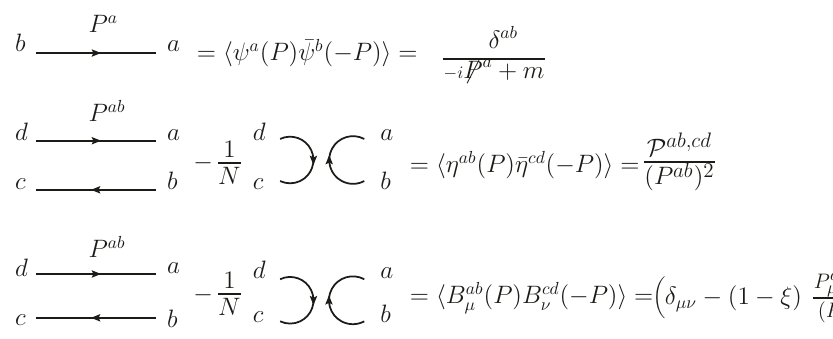
Figure 1 . The Feynman rules for quark, ghost and gluon propagators in double line basis. adjoint color index ab . With these C -dependent momenta, the covariant derivatives acting upon the fermionic